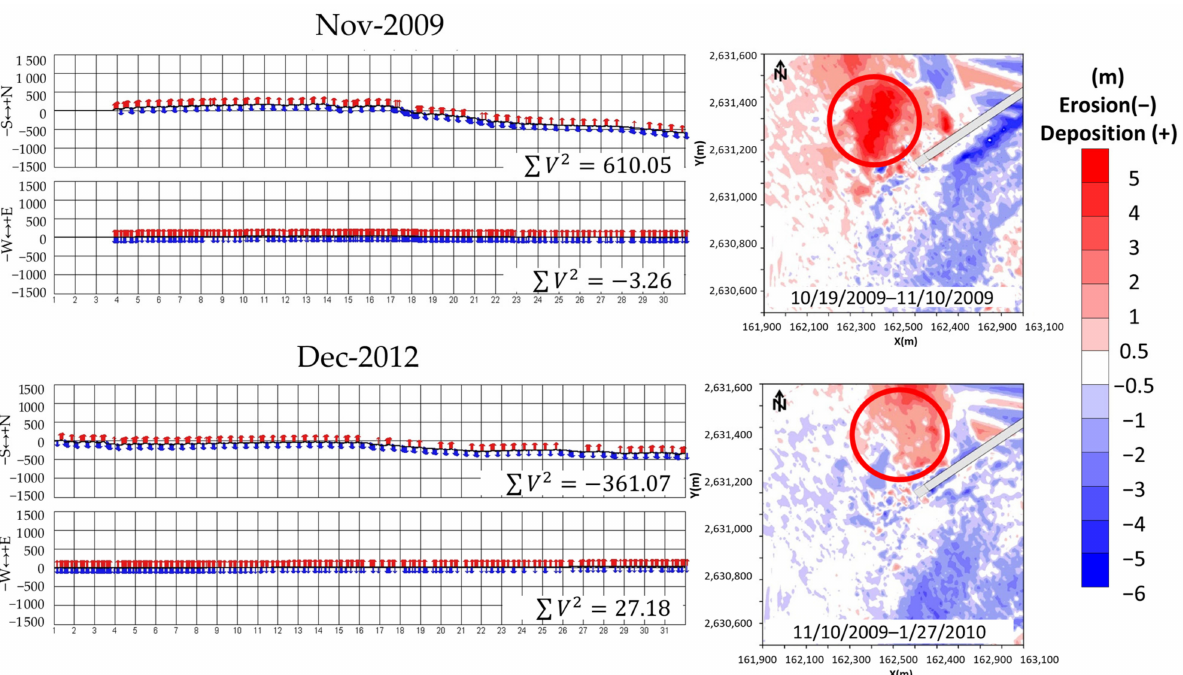
Figure 18. The accumulated energy at station YLCW and topographic change near the West Breakwa- ter in winter (one-month